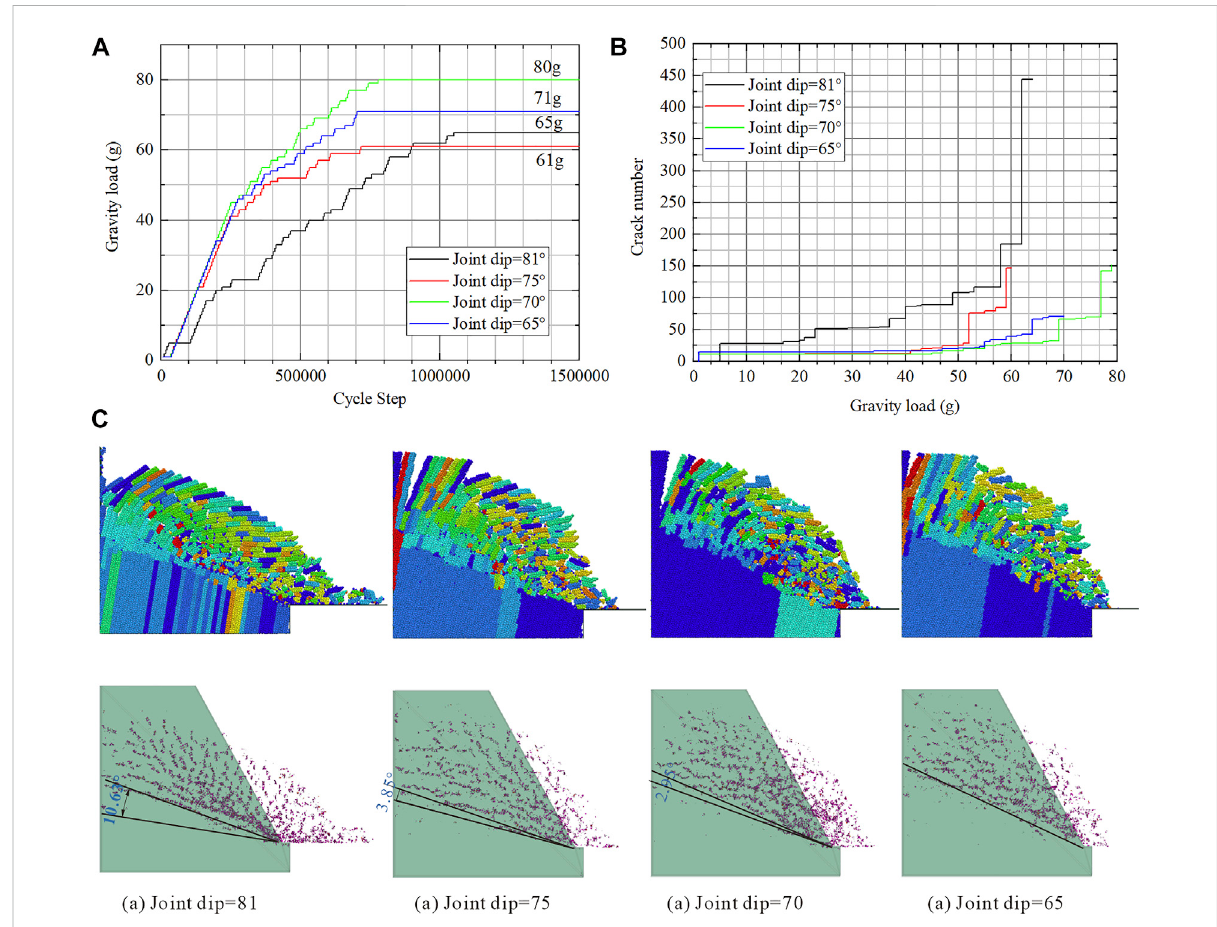
FIGURE 14 Effect of the joint dip on slope stability: (A) collapse load; (B) crack number; and (C) post-failure con fi